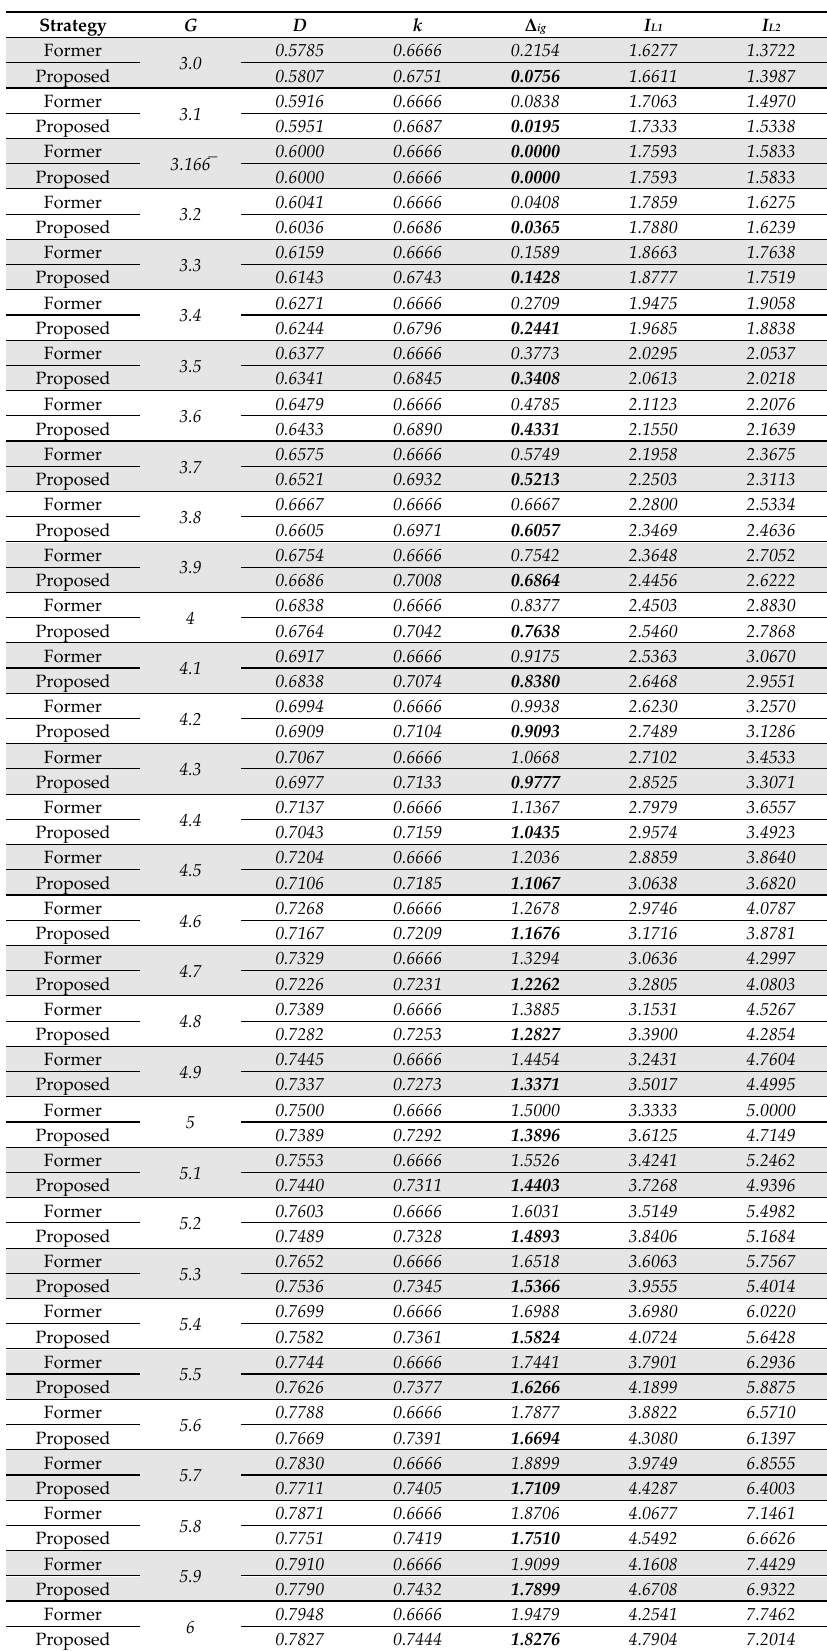
Table 2. Comparative table of the obtained results with the former and the proposed strategy.